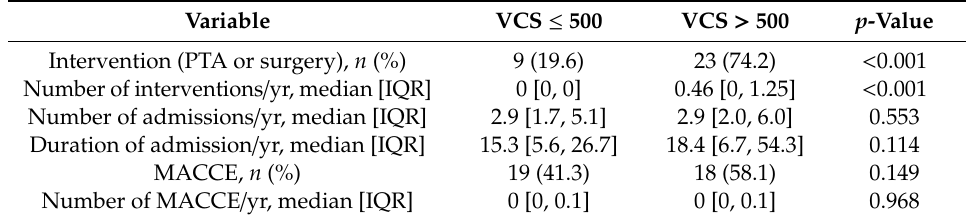
Table 3. Incidence of events.